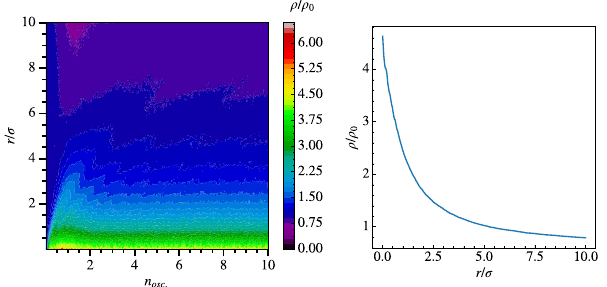
FIG. 21. MDM molecule density as a function of the radius and time (left) and the end time-averaged local molecule density versus radius (right). The molecule density is normal- ized with respect to the initial (or space-averaged) molecule density. In this simulation, the molecules are at a temperature T=T (cid:3) ¼ 0 . 1 , and the particles initially distributed throughout μ the transverse x - y